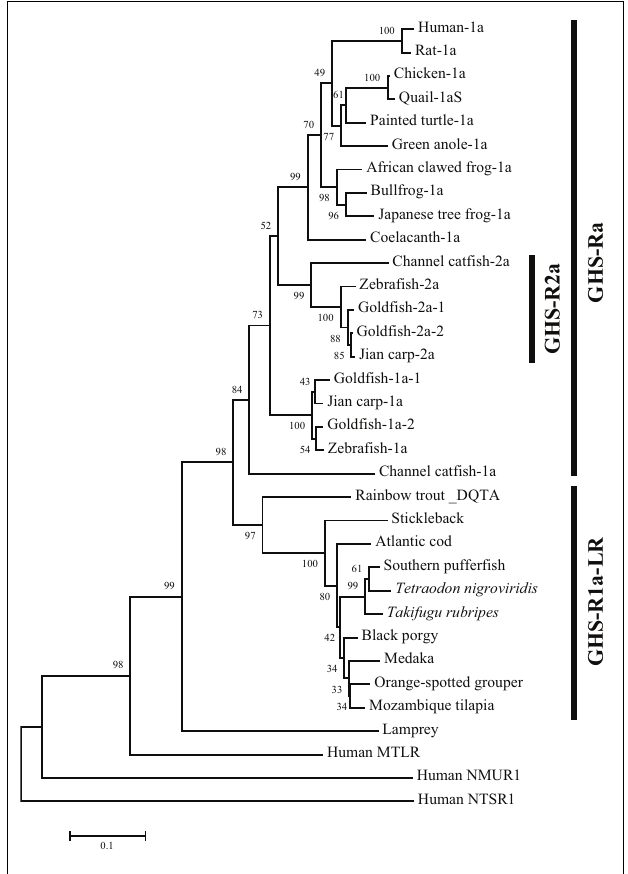
FIGURE 2 | Phylogenetic tree of GHS-Ra and GHS-R1a-LR in non-mammalian vertebrates .The phylogenetic tree was constructed by using the neighbor-joining method with MEGA4 (http://www.megasoftware.net/).The numbers on the branch points are the bootstrap values (as percentages based on 2000 replicates).The scale bar indicates the average number of substitutions per position (a relative measure of evolutionary distance). Receptors for human motilin (MTLR), neuromedin-U (NMUR1), and neurotensin (NTSR1) were used as the